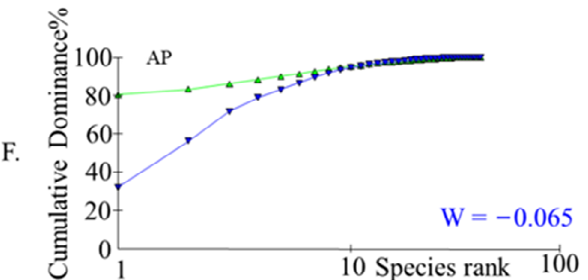
Figure 7. Comparison of ABC curve results in different lake areas of Gehu Lake. ( A , B ) represent the results for the entire lake area, ( C , D ) represent the results for the northern protected area, and ( E , F ) represent the results for the lake area outside the northern protected area. IP represents the sampling results from 2017 to 2018 and AP represents the sampling results from 2021 to 2022.